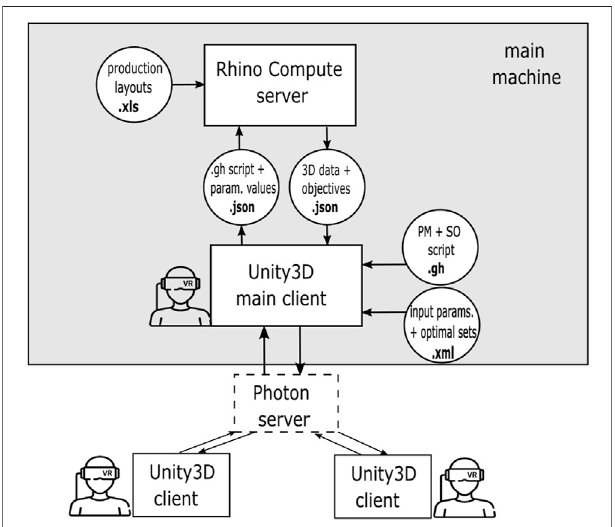
FIGURE 3 | BIMFlexi-VR framework. Abbreviations: PM, parametric modelling; SO, structural optimization.